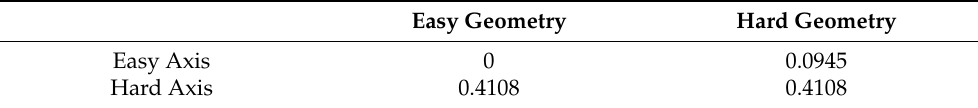
Table 4. Relative energies (in meV/f.u.) for the various configurations of spin and geometry in PtMn. The easy geometry is the ground-state geometry of the system, and the hard geometry is the geometry of the system having been relaxed under the constraint that the system is aligned along the magnetic hard